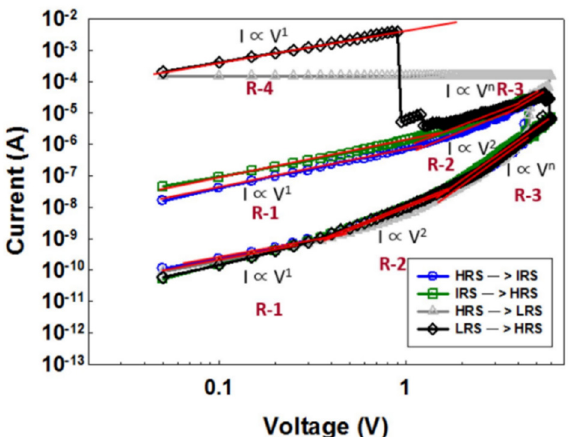
Figure 3. log (I) − log (V) characteristics of an Au / Ni / SiO x N y / p + -Si memory device with I COMP = 0.25 mA.